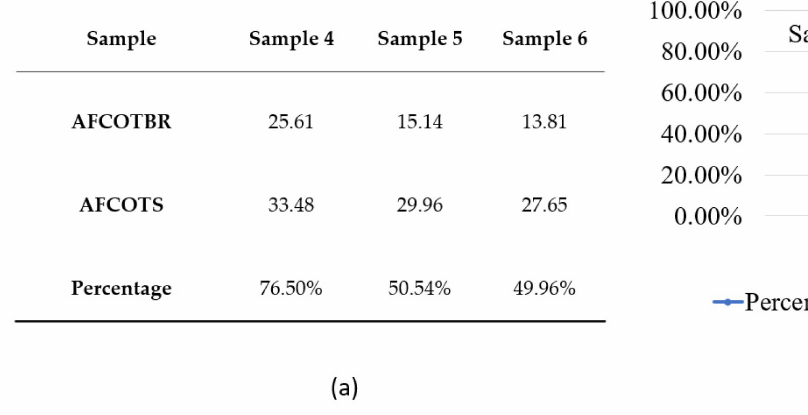
Figure 12. Analysis of the fixation points in the experiment 2: ( a ) Data related to the number of fixation points in the experiment 2 and ( b ) relationship between the percentage of AFCOTBR to AFCOTS, and the S/L ratio (the experiment